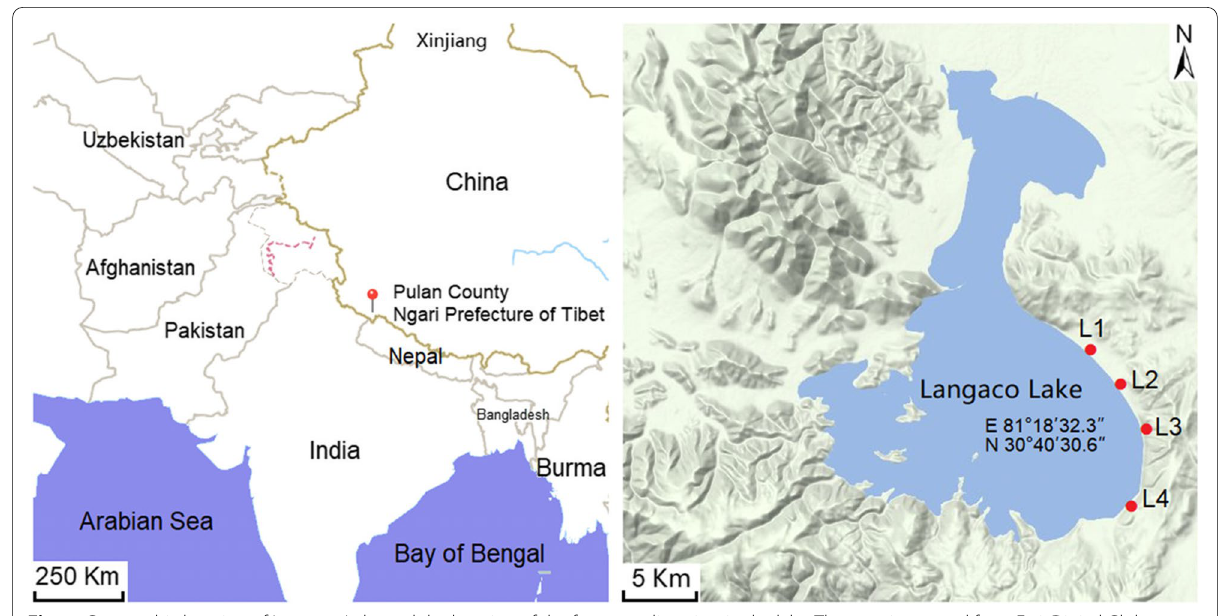
Fig. 1 Geographic location of Langaco Lake and the location of the four sampling sites in the lake. The map is sourced from Esri, Digital Globe, GeoEye, Earthstar Geographics, CNES/Airbus DS, USDA, USGS, AeroGRID, IGN, and the GIS User